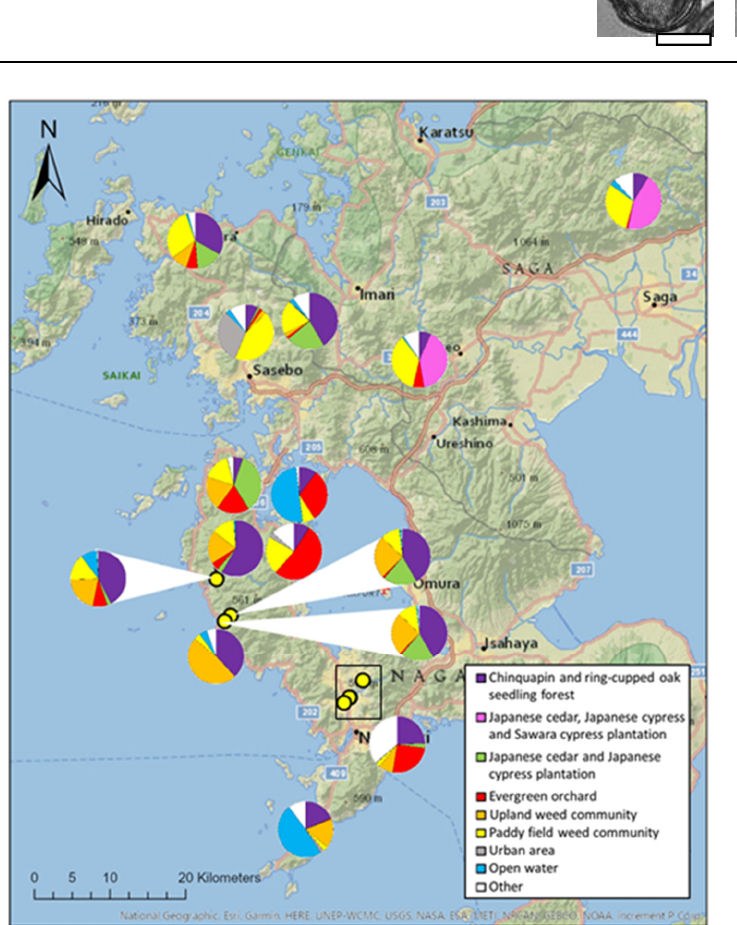
Table 2. Statistical analysis of the effect of rural-to-urban ratio of land use on composition of sugars found in honey col- lected by 22 colonies of Japanese honeybee in various locations within Kyushu, Japan, between June 2018 and August 2019. Statistical values for rural-to-urban ratios within radii of 1, 3 and 5 km were calculated. N for all statistics was 22. All maltose values were calculated using Pearson’s product-moment correlation (r) and all fructose and glucose values were calculated using Spearman’s rank correlation (r s ).